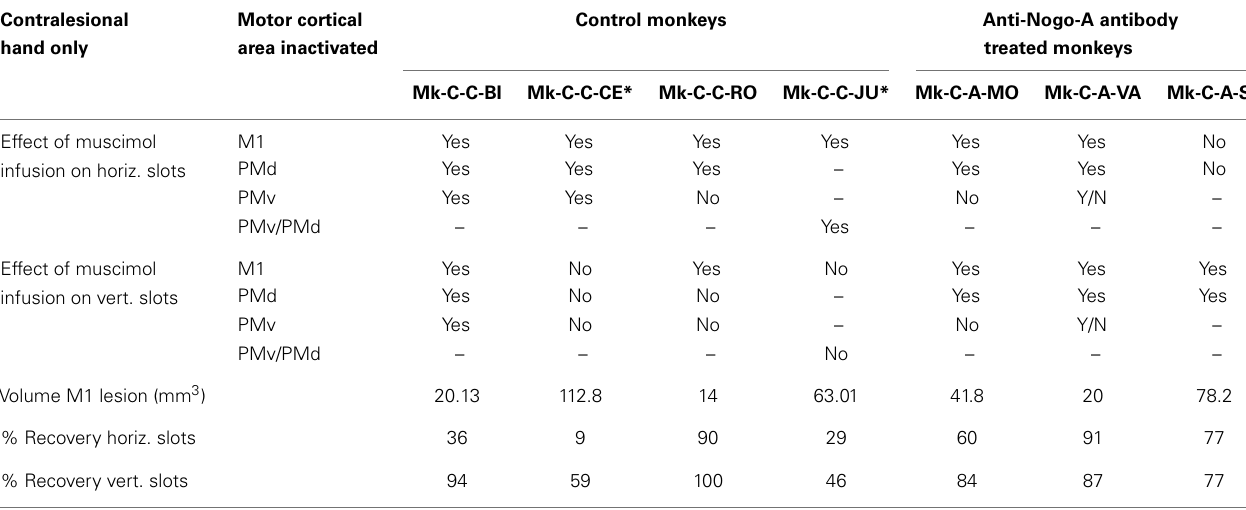
Control monkeys